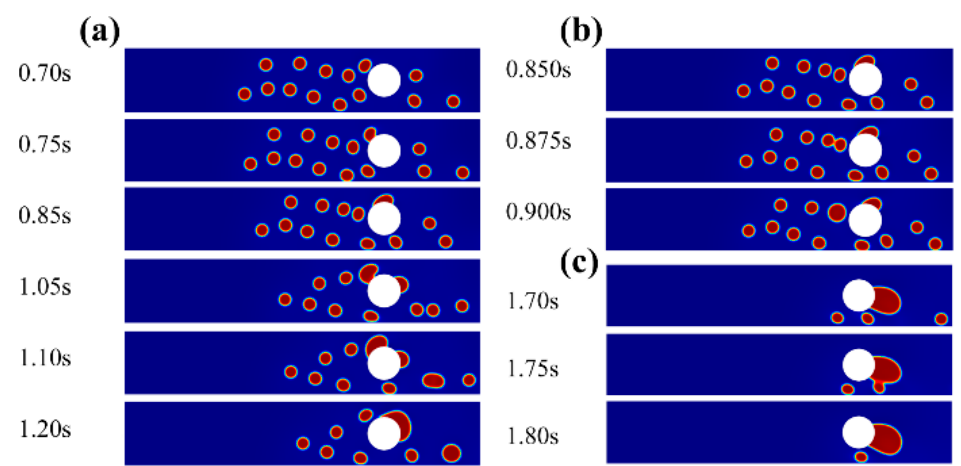
Figure 5. Dynamic behaviour of water droplets flowing through the medium with an applied electric field. ( a ) The whole process. ( b ) The spreading behavior of adhered droplet by fluid drag force. ( c ) The direct capture behavior of merged droplet on medium surface .